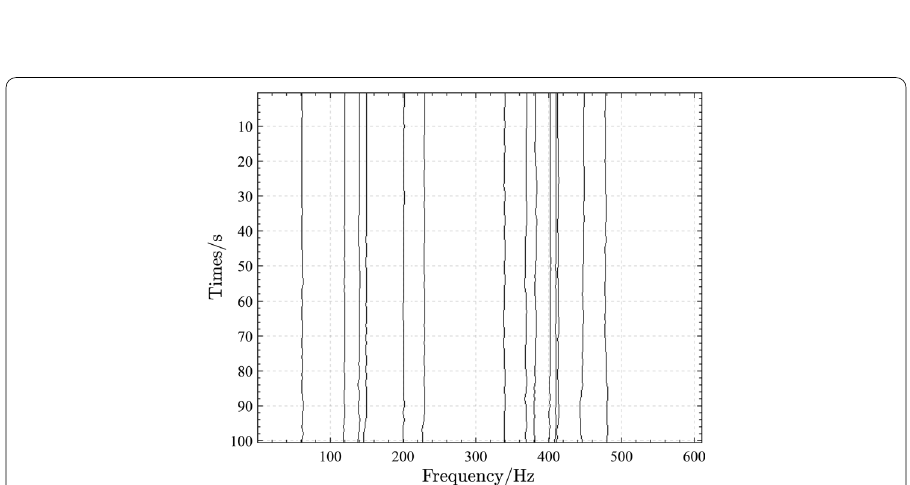
Fig. 18 Extraction results of proposed algorithm for first set of sea-trial data